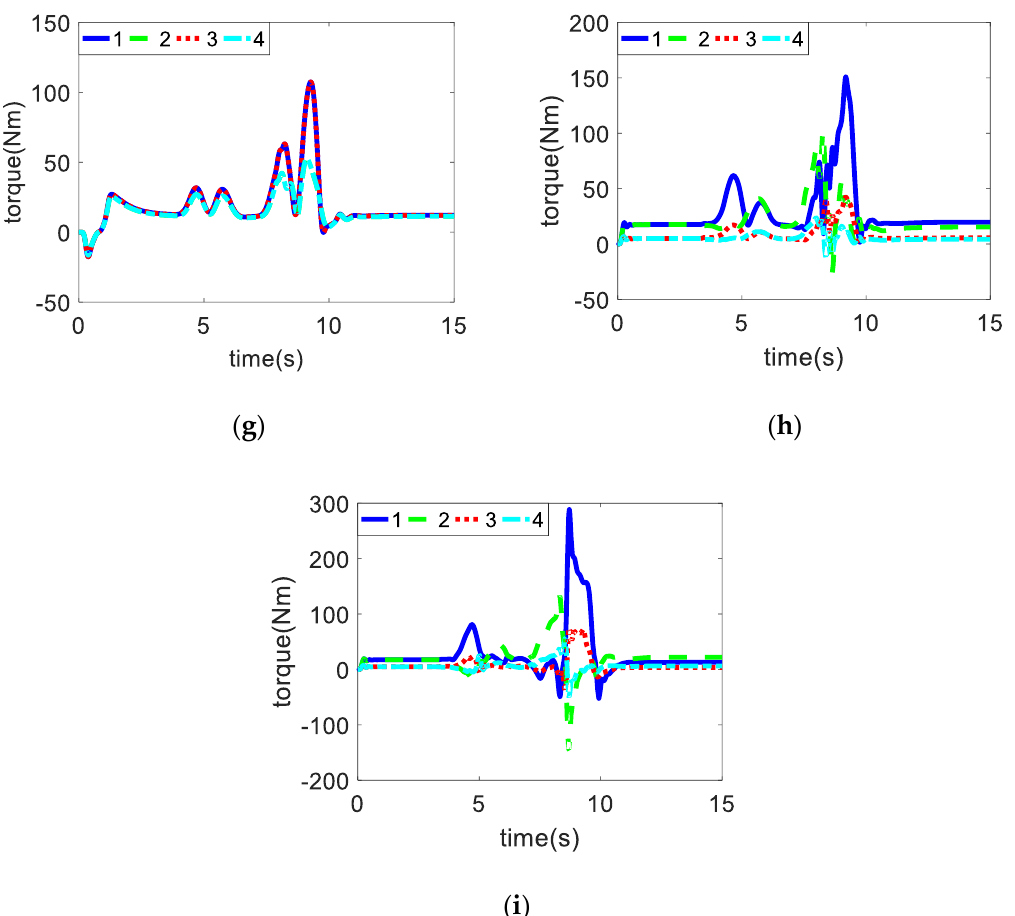
Figure 7. Simulation results for DLC on µ -split road ( µ = 0.75–0.2). ( a ) adhesion coefficient. ( b ) track. ( c ) speed. ( d ) yaw rate. ( e ) sideslip angle. ( f ) phase plane. ( g ) torque under the speed control. ( h ) torque under the common control. ( i ) torque under the adaptive control.